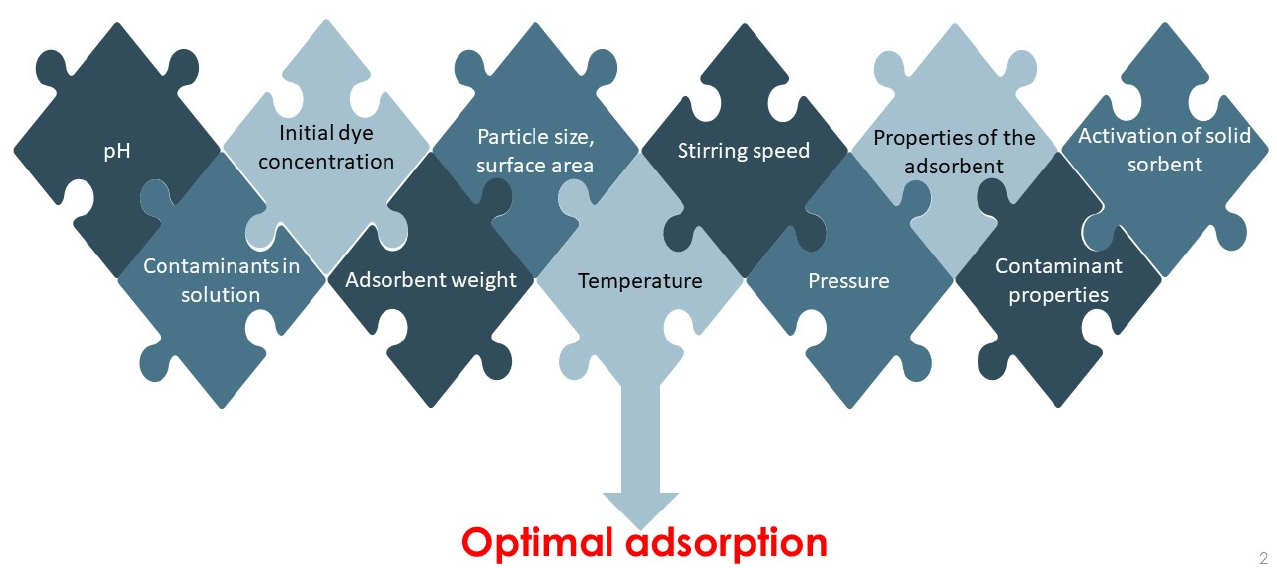
Figure 5. Factors affecting adsorption process.